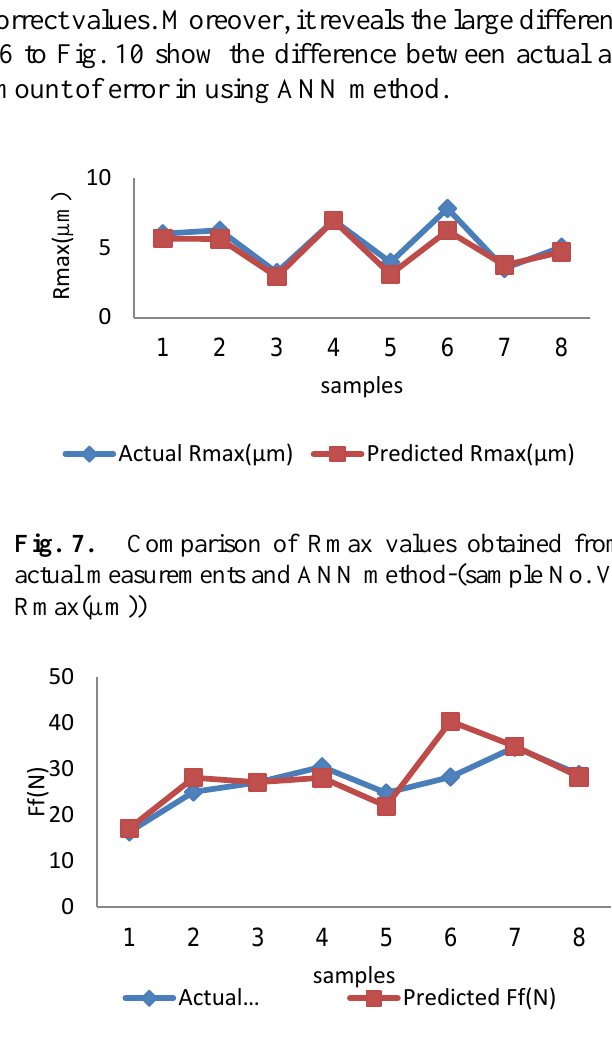
Fig. 9. Comparison of Ff values obtained from actual measurements and ANN method-(sample No. Vs Ff(N))